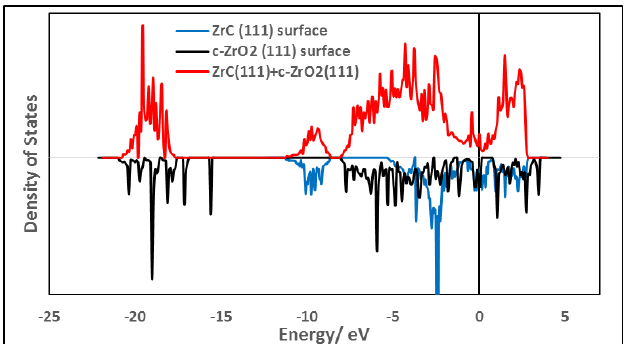
Figure 8. Comparison of the TDOS of interfacial structure Zr|OO|Zr|OO—ZrC(111) (on top ) with the TDOS of the bare surfaces (on the bottom ). An interface model with four layers of c -ZrO 2 (111) is used.